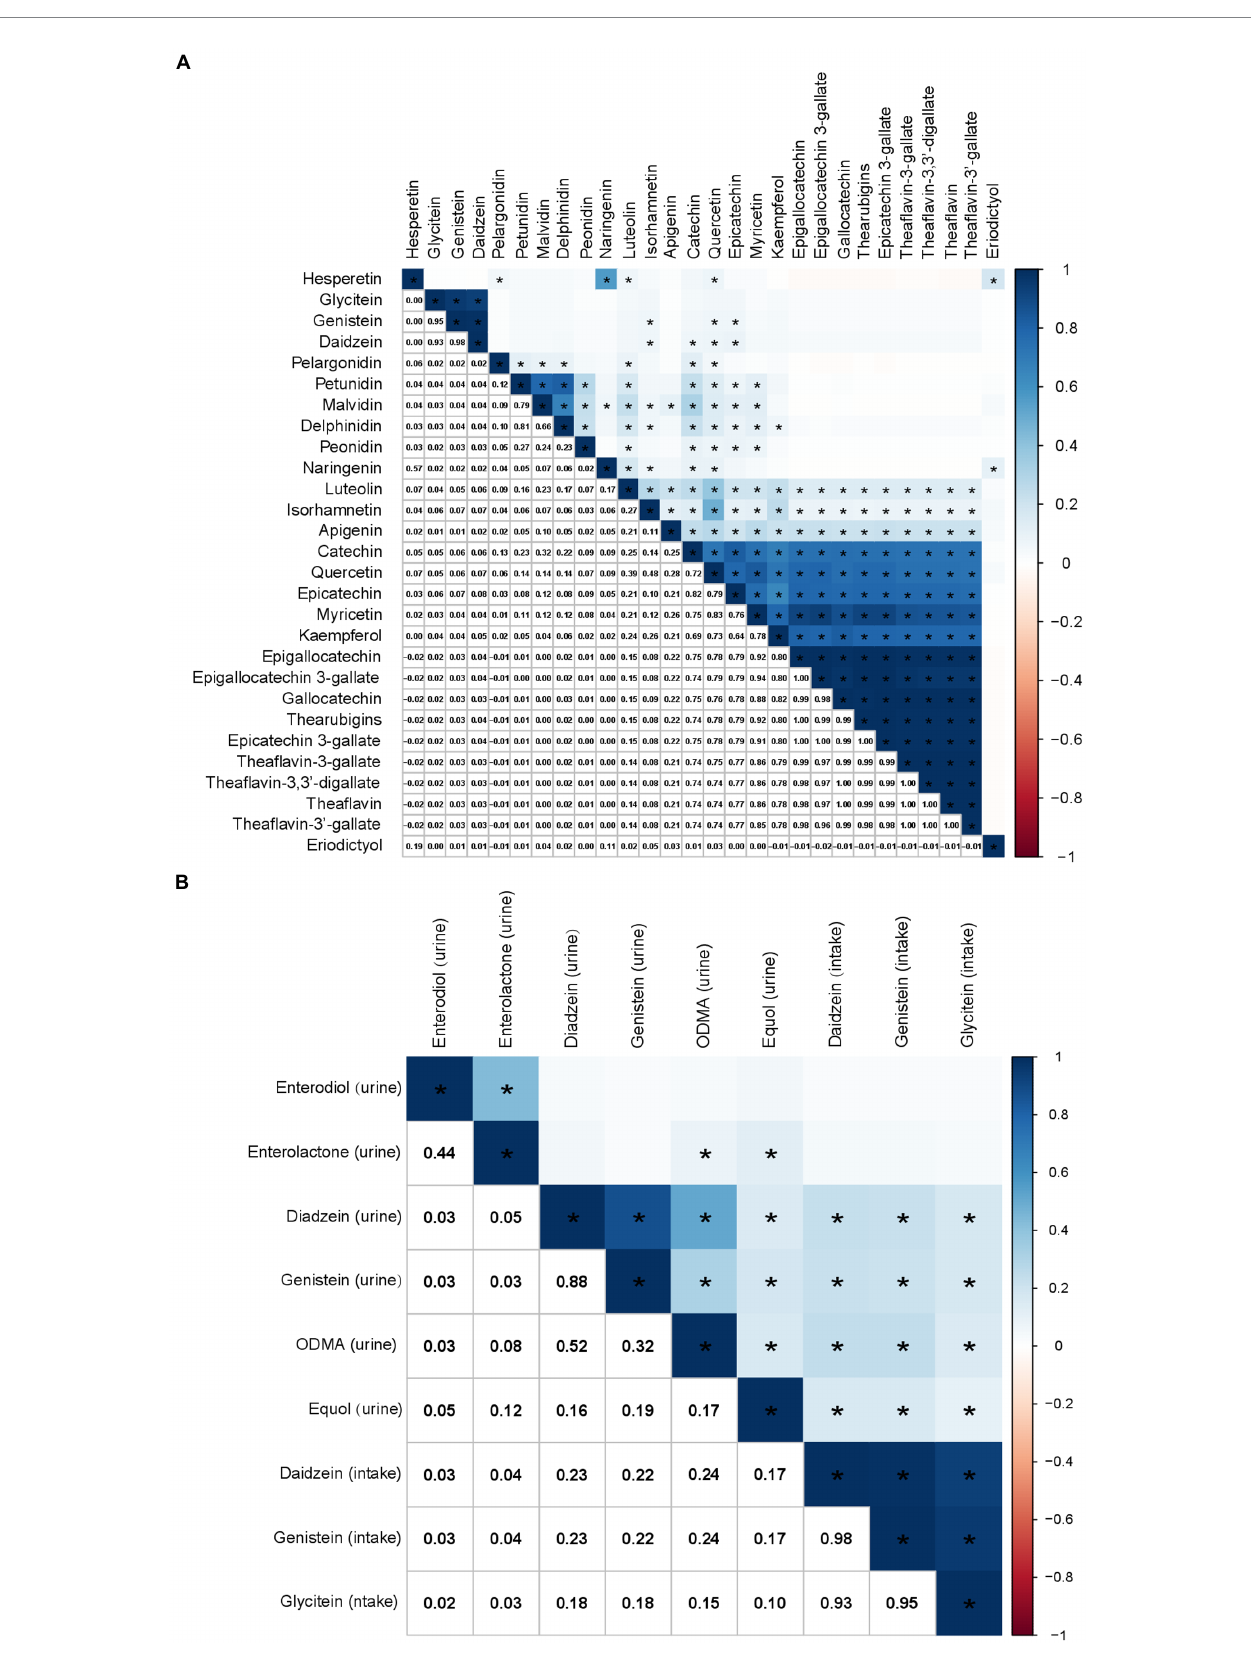
FIGURE 3 Correlations among flavonoid intakes (A) and the correlation between isoflavone intake and urinary phytoestrogens (B) , calculated by Pearson’s method. The numbers in the lower left half of the correlation graph represent the Pearson’s correlation coefficients. The color bars represent the Pearson’s correlation coefficients, dark blue as positive correlation and red as negative correlation. * p <